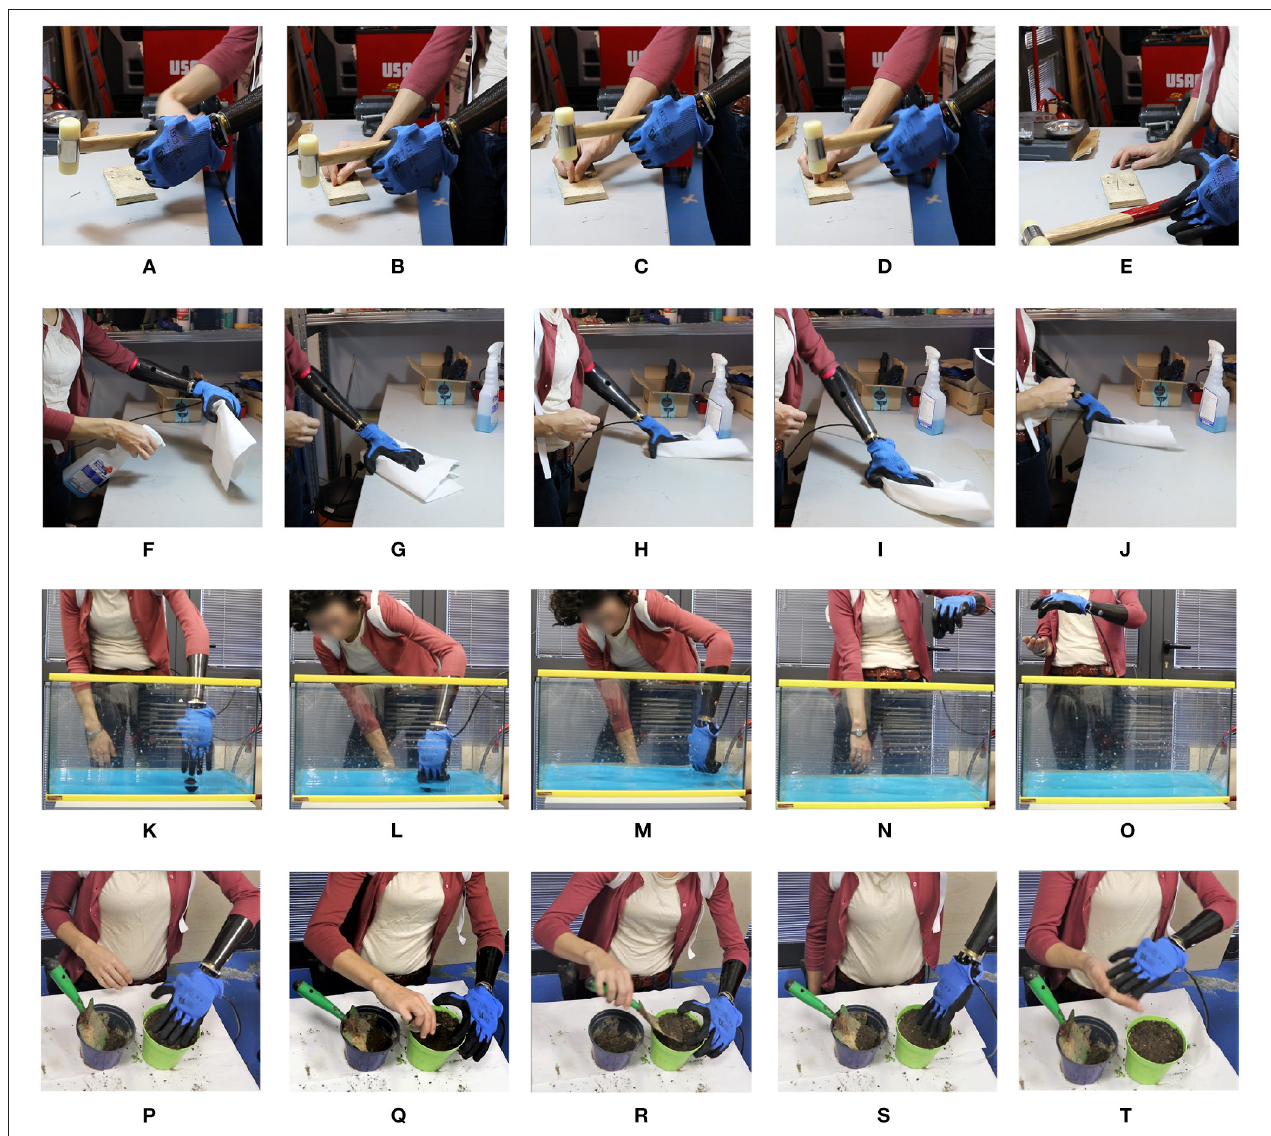
FIGURE 10 | Still images from various work tasks performed by a subject with limb-loss using the Hardy Configuration. From top to bottom the tasks are: hammering a nail (A–E) , wiping down a work surface (F–J) , retrieving an item in water (K–O) , and planting seeds (P–T) .